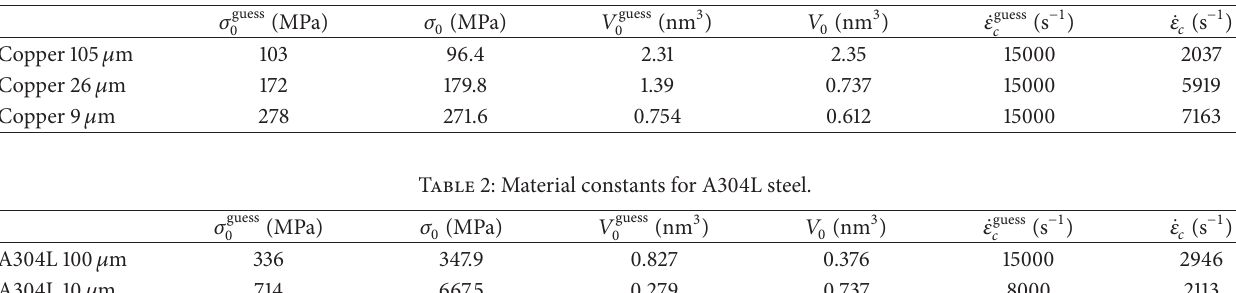
Figure 1: Comparison between experimental data (Couque [4]) and new modified Eyring equation for copper: (a) first-guess material constants and (b) optimized materials constants. Table 1: Material constants for copper.